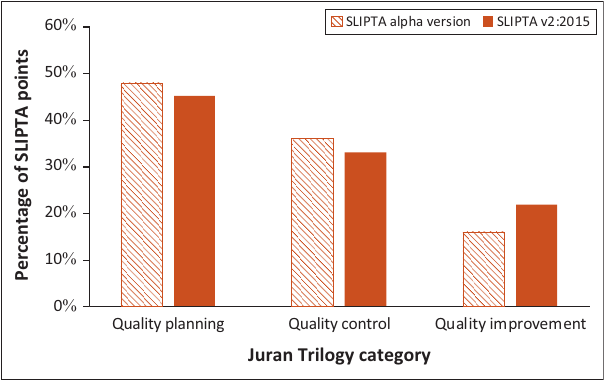
FIGURE 2: Relative point distribution of the scoring system of Stepwise Laboratory Quality Improvement Process Towards Accreditation checklist alpha version and version 2:2015 over the different categories of the Juran